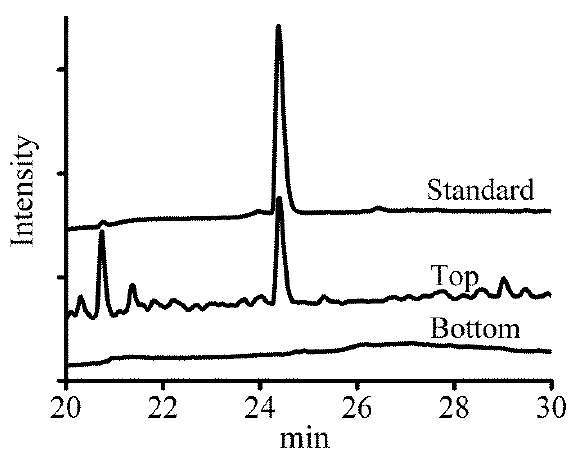
Figure 1. HPLC-UV chromatogram of solasodine from microwave-assisted aqueous two-phase system extraction (MAATPE).